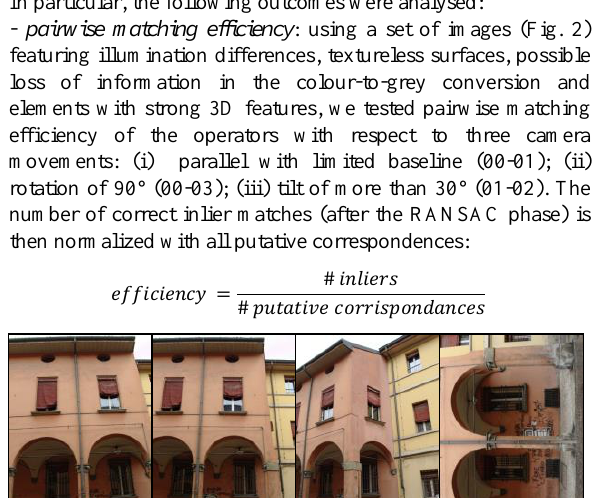
Porticoes dataset).